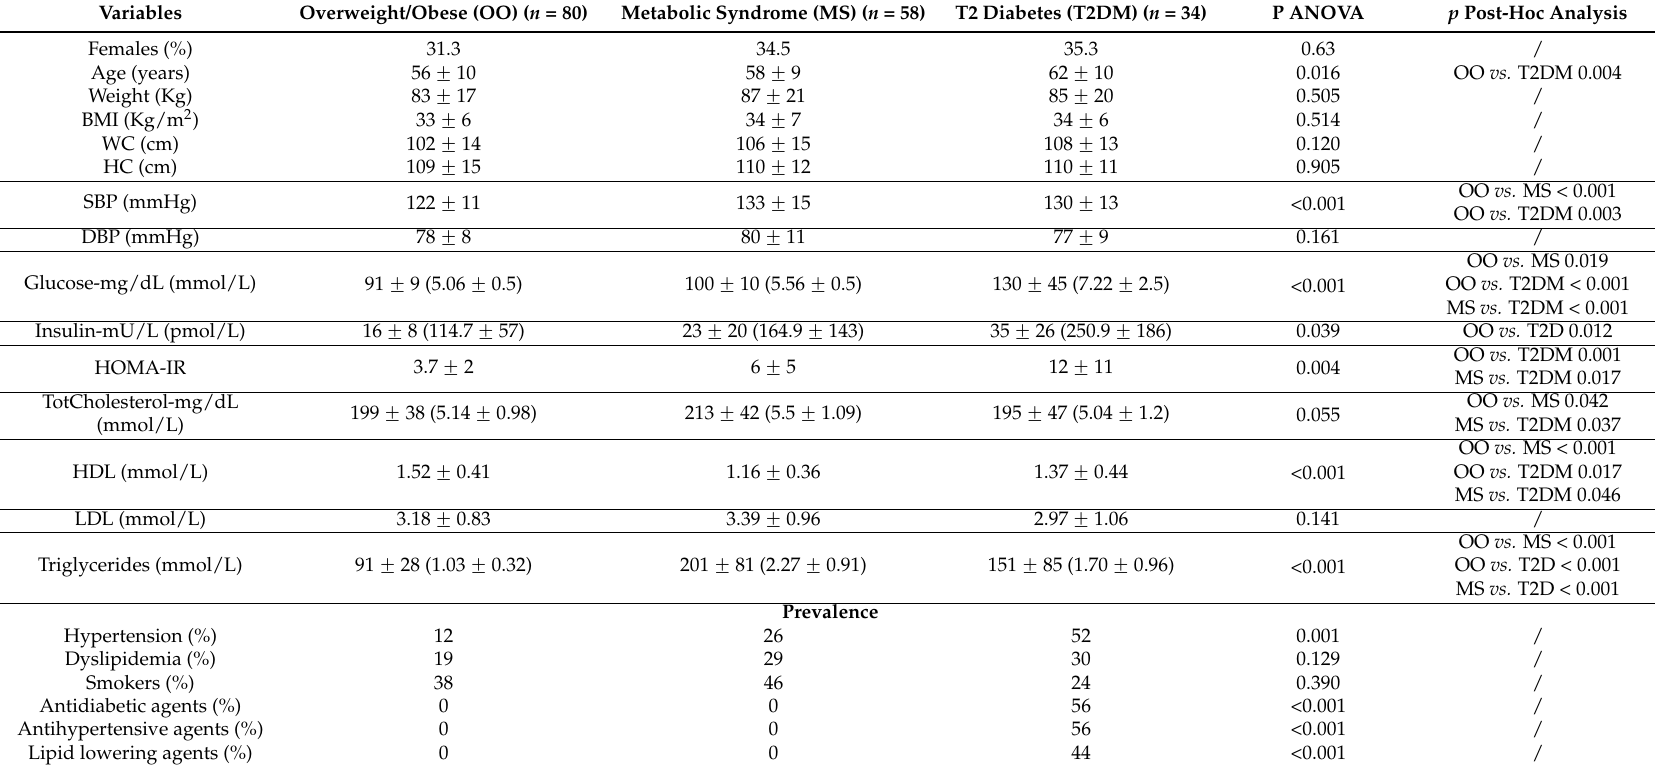
Table 1. Demographic, anthropometric and clinical characteristics of the